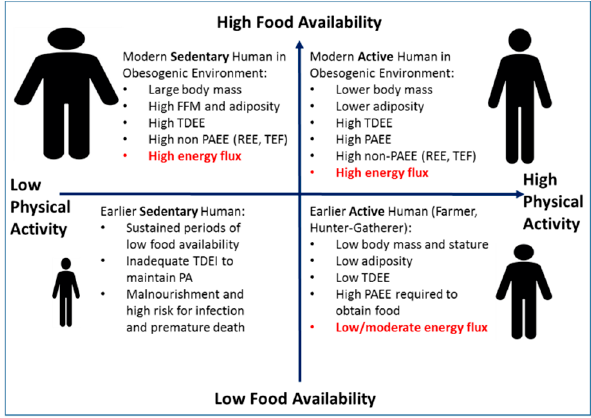
Figure 1. Total daily energy expenditure (TDEE) and body size are environmentally determined largely by the interaction of food availability (y-axis) and the need for physical activity (x-axis). Adapted from Pontzer [23].